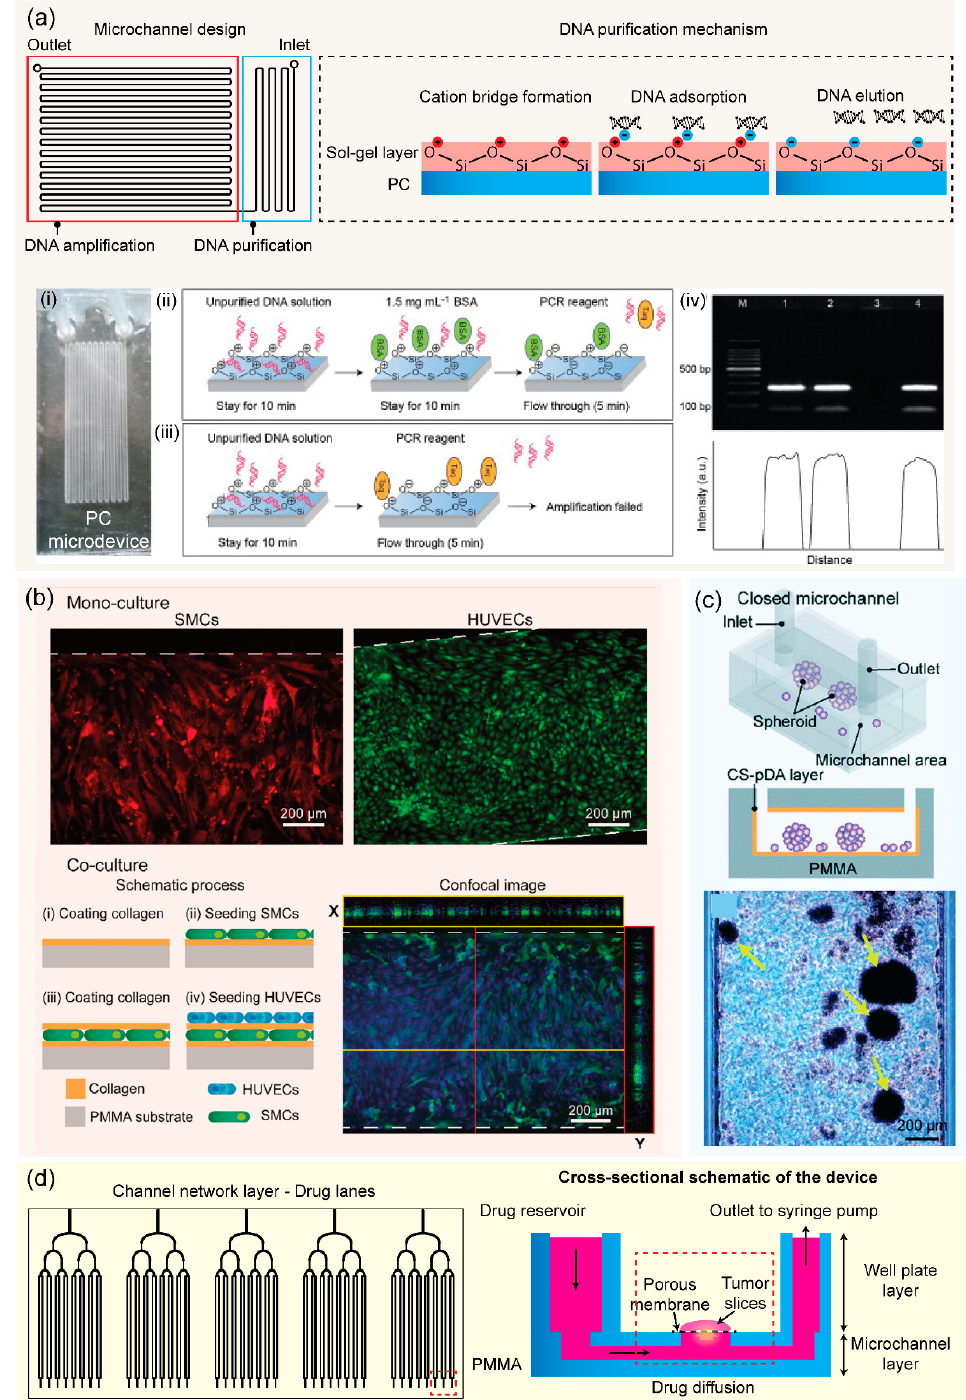
Figure 6. ( a ) Schemes illustrating a sol ‐ gel coated polycarbonate (PC) microdevice for DNA purification and amplification, results of capturing of DNA using sol ‐ gel coating layers used for DNA purification: (i) a photo of the purification microdevice, (ii,iii) schematic showing DNA elution using PCR reagent inside the microchannel with and without BSA treated, respectively, (iv) results of the PCR performed from the on ‐ chip purification. Adapted with permission from Ref. [106]. Copyright 2014, Elsevier. ( b ) Results showing successful culture of SMCs and HUVECs inside a bonded PMMA microdevice using poly(acrylic acid) as an adhesion agent, schemes illustrating a layered co ‐ culture model of SMCs and HUVECs using a poly(methyl methacrylate) (PMMA) mi ‐